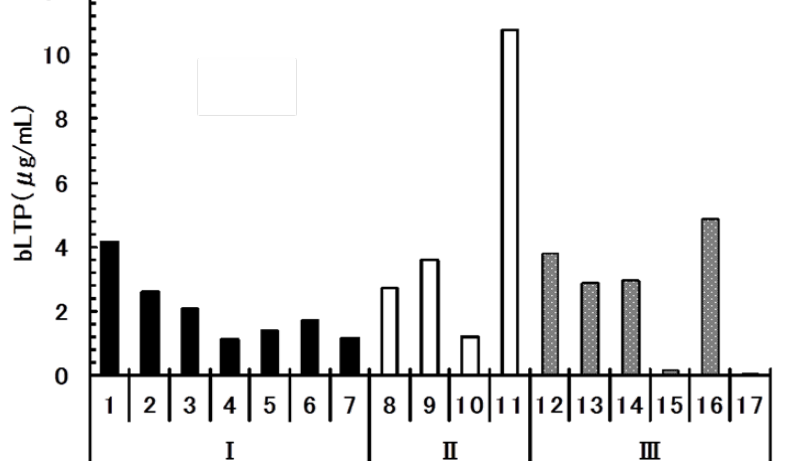
Figure 6. Barley LTP levels in beer samples prepared by three different brewing processes. Concentration of bLTP was determined by the 10-4/5-4 sandwich ELISA system. Ⅰ , bottom fermentation; Ⅱ , top fermentation; Ⅲ , spontaneous fermentation. No. 1–7, Japanese